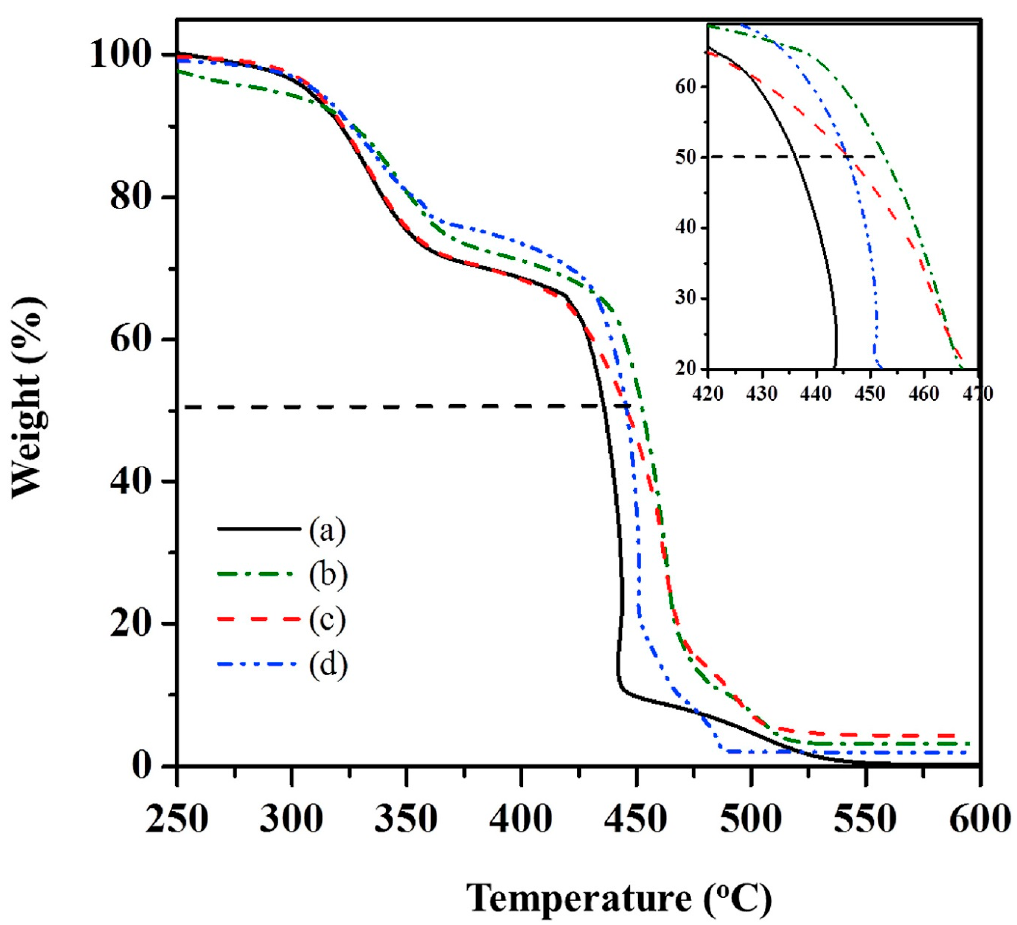
Figure 4. Thermogravimetric analysis curves of ( a ) neat EVA, ( b ) 6-phr DS-LDH/EVA, (c) DBS- Figure4. Thermogravimetricanalysiscurvesof( a )neatEVA,( b )6-phrDS-LDH / EVA,( c )DBS-LDH / EVA, LDH/EVA, and (d) SA-LDH/EVA. The zoomed area corresponds to the TGA curves at temperatures and ( d ) SA-LDH / EVA. The zoomed area corresponds to the TGA curves at temperatures from 420 to from 420 to 470 o C. Adapted from Lee, J-H.; Zhang, W.; Ryu, H-J.; Choi, G.; Choi, J.Y.; Choy, J-H. 470 ◦ C